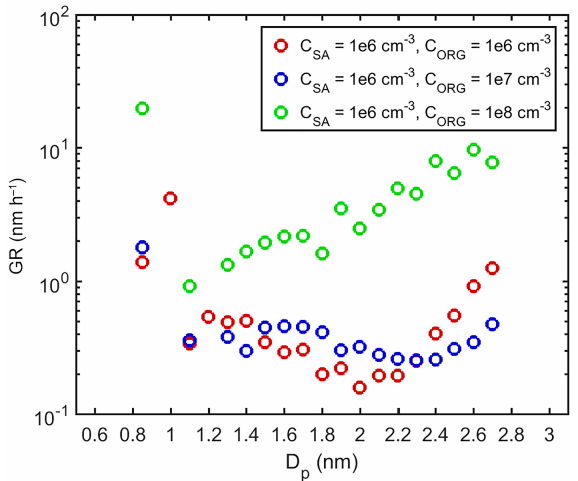
Figure A4. GRs determined for different size bins in simulations with SA–NH 3 and LVOC. The colors indicate vapor concentrations in each